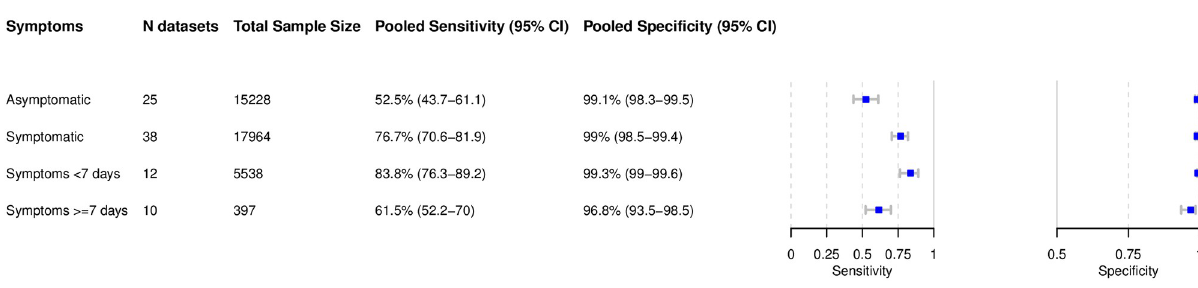
Fig 9. Pooled sensitivity and specificity by presence of symptoms and symptom duration. In addition, it was possible to meta-analyze test-specific pooled sensitivity for Panbio: 97.7% sensitivity (95% CI 95.3% to 98.9%) for Ct value < 20, 95.8% (95% CI 92.3% to 97.8%) for Ct value < 25, and 83.4% (95% CI 69.1% to 91.9%) for Ct value < 30. Sensitivity was 61.2% (95% CI 38.8% to 79.7%) for Ct value � 25 and 30.5% (95% CI 16.0% to 50.4%) for Ct value � 30. For the other Ag-RDTs only limited data were available, which are presented in S5 Fig. Subgroup analysis by IFU conformity. The summary results are presented in Fig 7. When assessing only studies with IFU-conforming testing, pooled sensitivity from 81 datasets with 49,643 samples was 76.3% (95% CI 73.1% to 79.2%). When non-IFU-conforming sam- pling (75 datasets, 31,416 samples) was performed, sensitivity decreased to 65.9% (95% CI 60.6% to 70.8%).